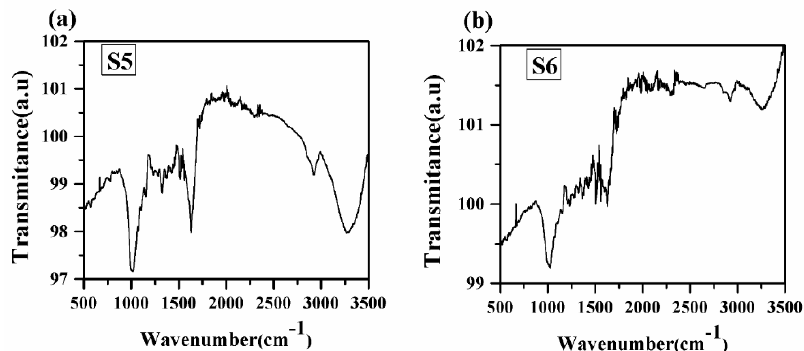
Figure 9. FTIR spectrum of turmeric samples S5 and S6. ( a ) Sample (S5); ( b ) Sample